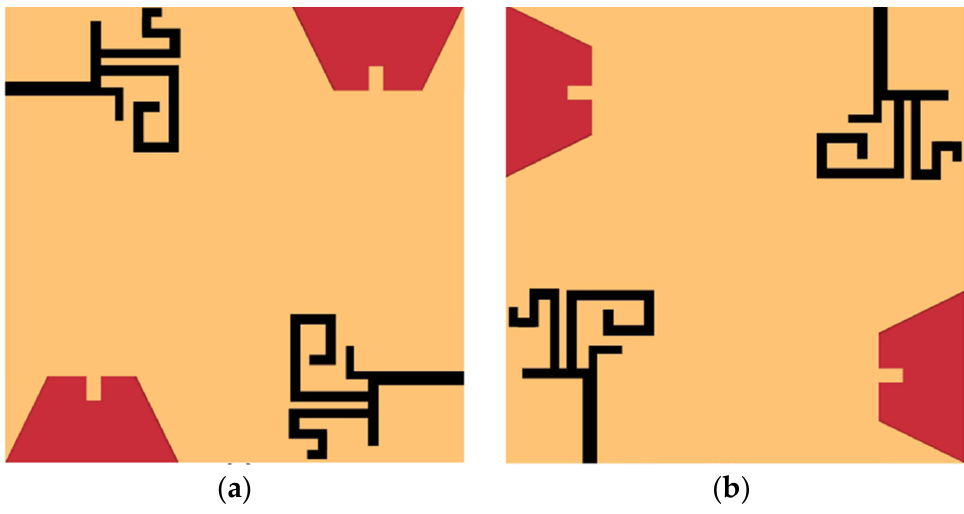
Figure 5. Proposed DS MIMO antenna ( a ) front side, ( b ) back side.